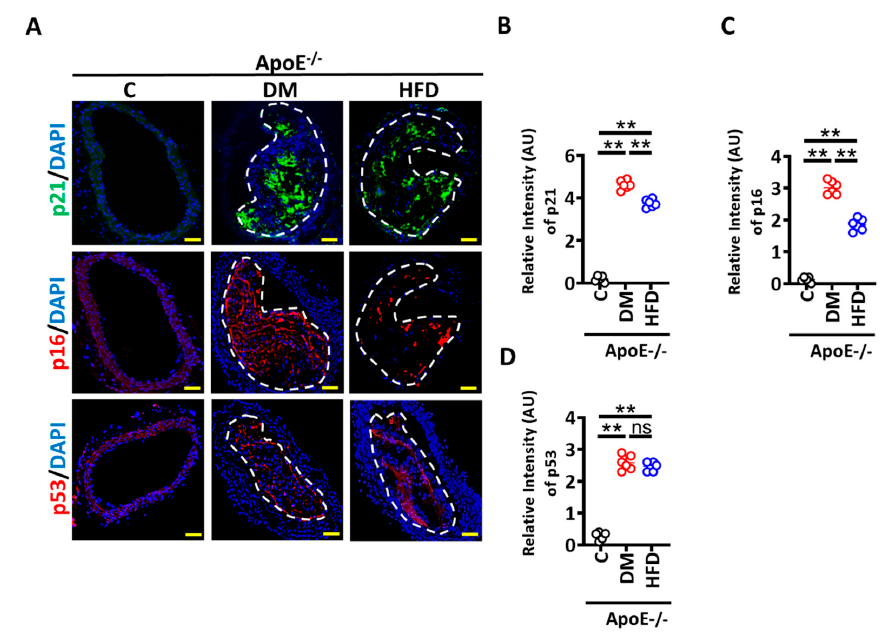
Figure 2. Senescence is induced within plaques of diabetic ApoE − / − mice. ( A ) Representative immunofluorescence images showing staining of brachiocephalic arteries for p21 (( A ), top panel, p21, green; nuclear counterstain: DAPI, blue), p16 (( A ), middle panel, p16, red; nuclear counterstain: DAPI, blue) and p53 (( A ), bottom panel, p16, red; nuclear counterstain: DAPI, blue). ( B – D ) Dot plots summarizing immunofluorescence data for p21 ( B ) p16 ( C ), p53 ( D ) and Scale bar: 20 µ m ( A ). ApoE − / − control mice (Cont, normal chow diet, citrate instead of streptozotocin injections), DM mice (normal chow diet, streptozotocin injections) or HFD mice (fed high fat diet). Each dot represents data obtained from one mouse specimen; ** p < 0.01;